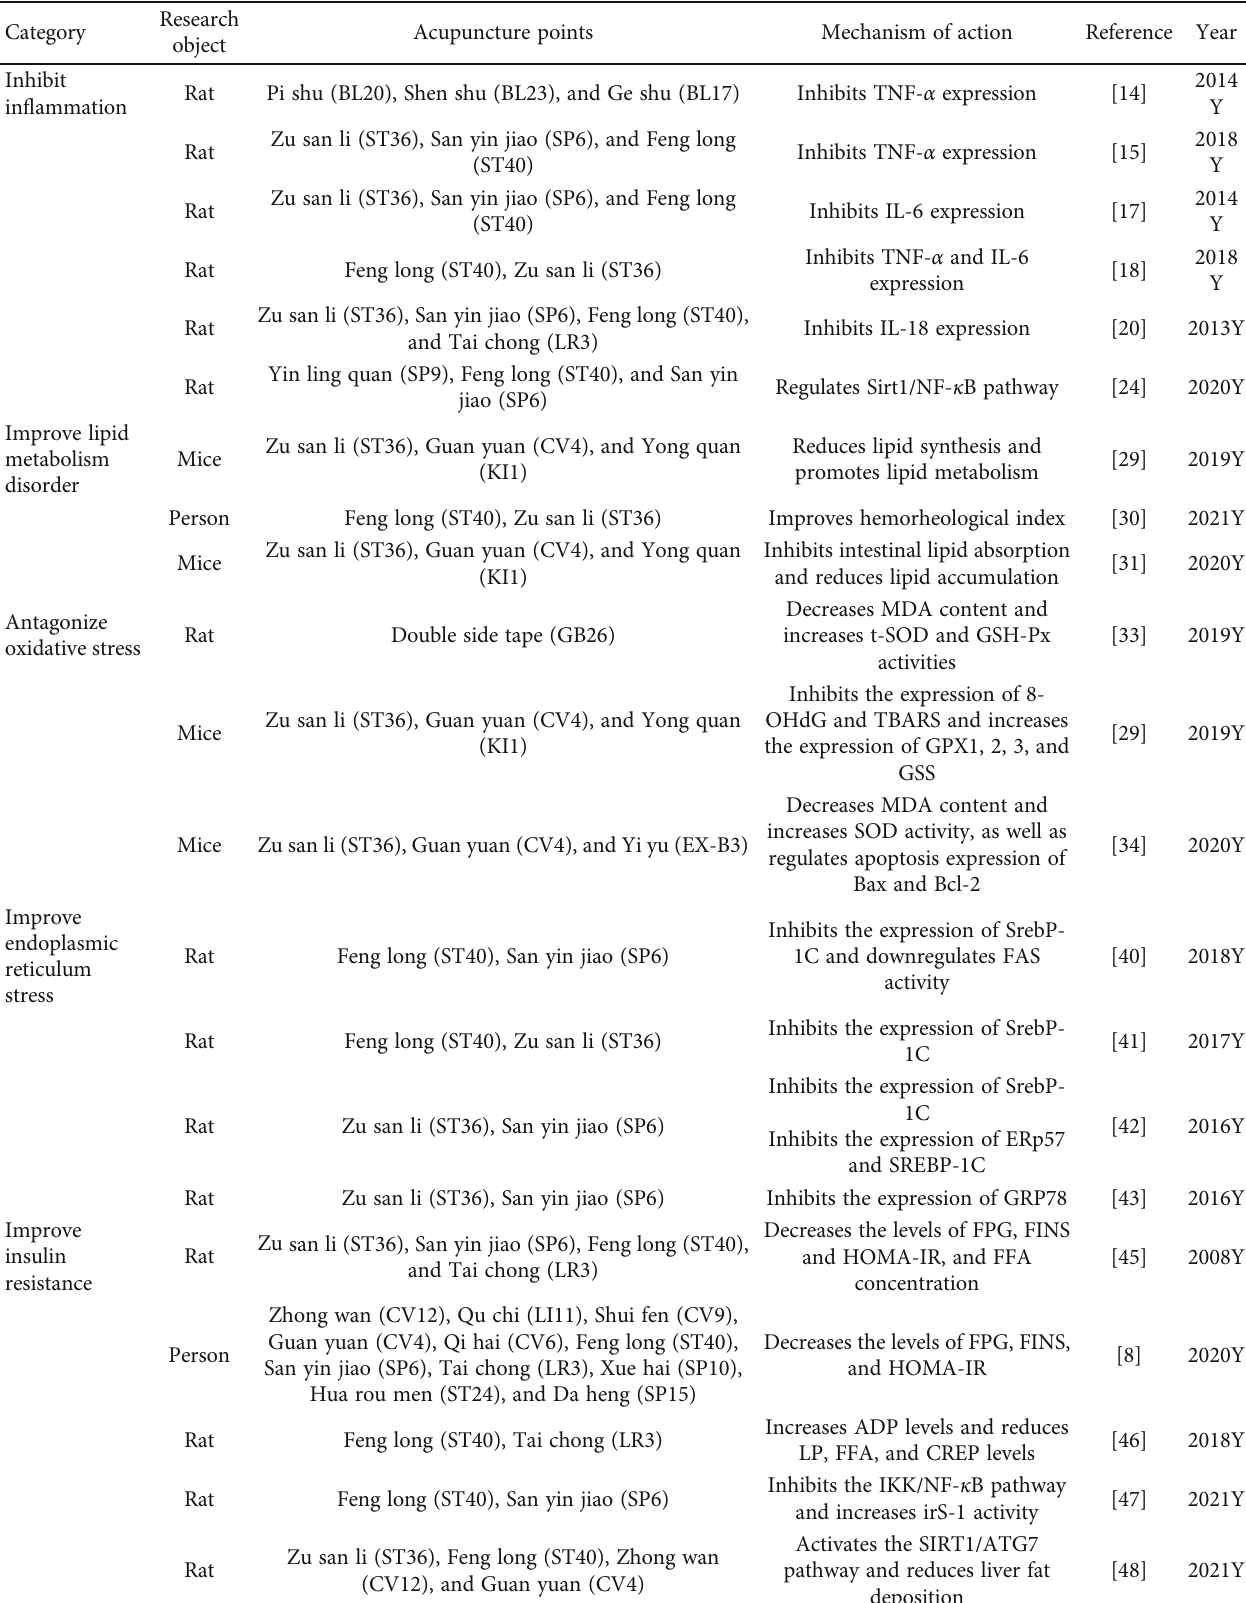
Table 1: Mechanisms of acupuncture intervention in nonalcoholic fatty liver